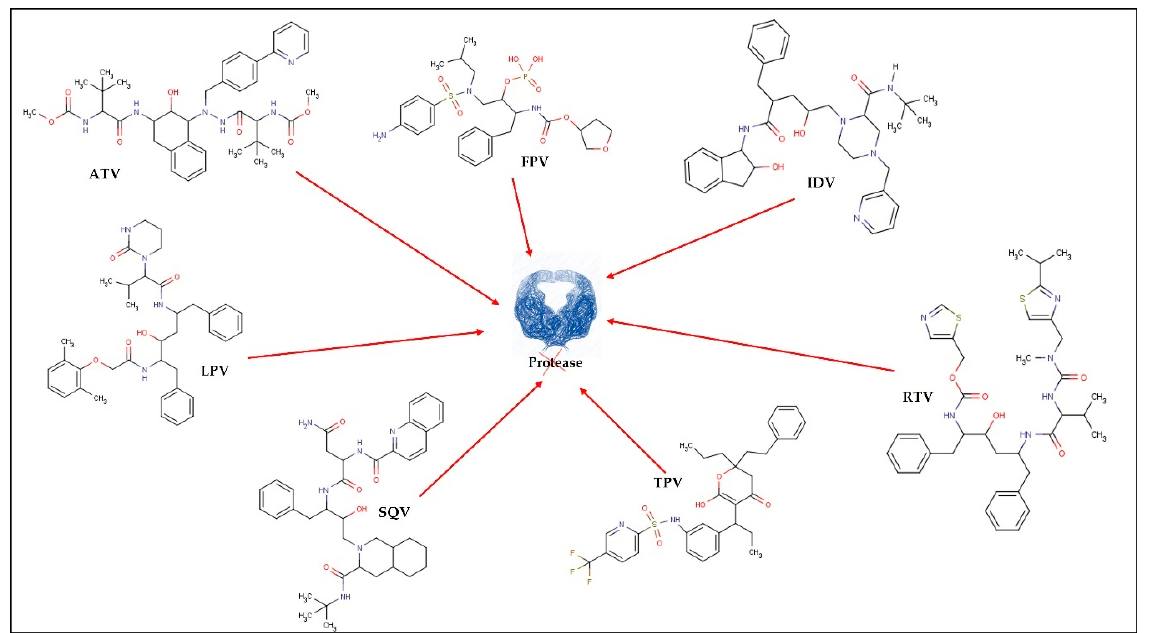
Figure 6. Protease inhibitors: tipranavir (TPV); indinavir (IDV); ritonavir (RTV); fosamprenavir (FPV); atazanavir (ATV); lopinavir (LPV); saquinavir (SQV).